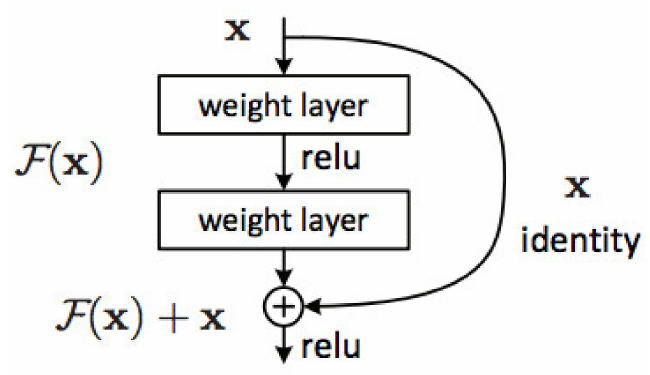
Figure 6. Residual learning: a building block